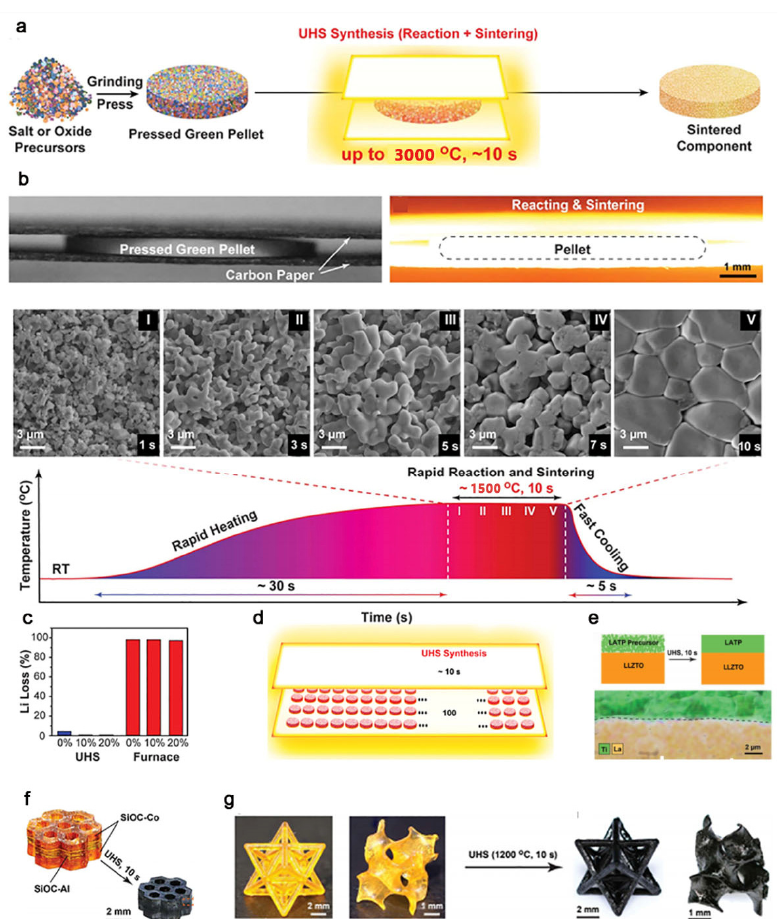
Figure 2. ( a ) Scheme for the protocol of the rapid sintering process; ( b ) the temperature profile of the ultrafast high-temperature sintering (UHS) process; ( c ) comparison of Li loss of different sintered Li 6.5 La 3 Zr 1.5 Ta 0.5 O 12 (LLZTO) samples (0, 10, and 20% excess Li) using the UHS technique and conventional furnaces; ( d ) scheme of high-throughput screening: co-sintering ~100 matrix with ~10 s; ( e ) schematics and energy dispersive spectroscopy mapping of the co-sintered Li 1.3 Al 0.3 Ti 1.7 (PO 4 ) 3 (LATP)-LLZTO bilayer SSE; ( f ) a multilayer 3D-printed SiOC polymer precursor and a corresponding UHS-sintered sample; and ( g ) snapshots of the SiOC polymer precursor and SiOC samples sintered by the UHS method. Reproduced with permission [45]. Copyright 2020, AAAS. RT, room temperature.